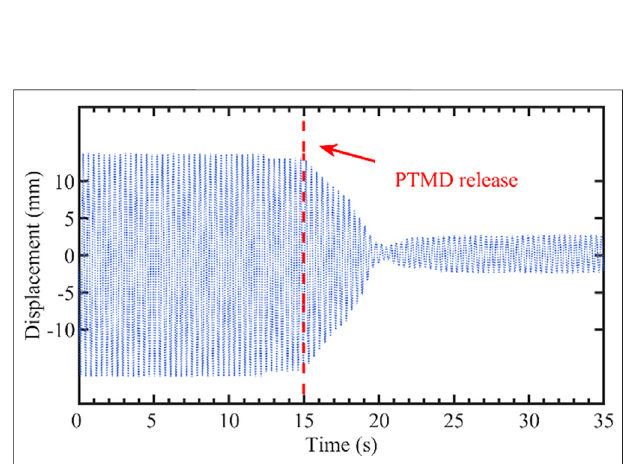
FIGURE 5 | Portal frame with